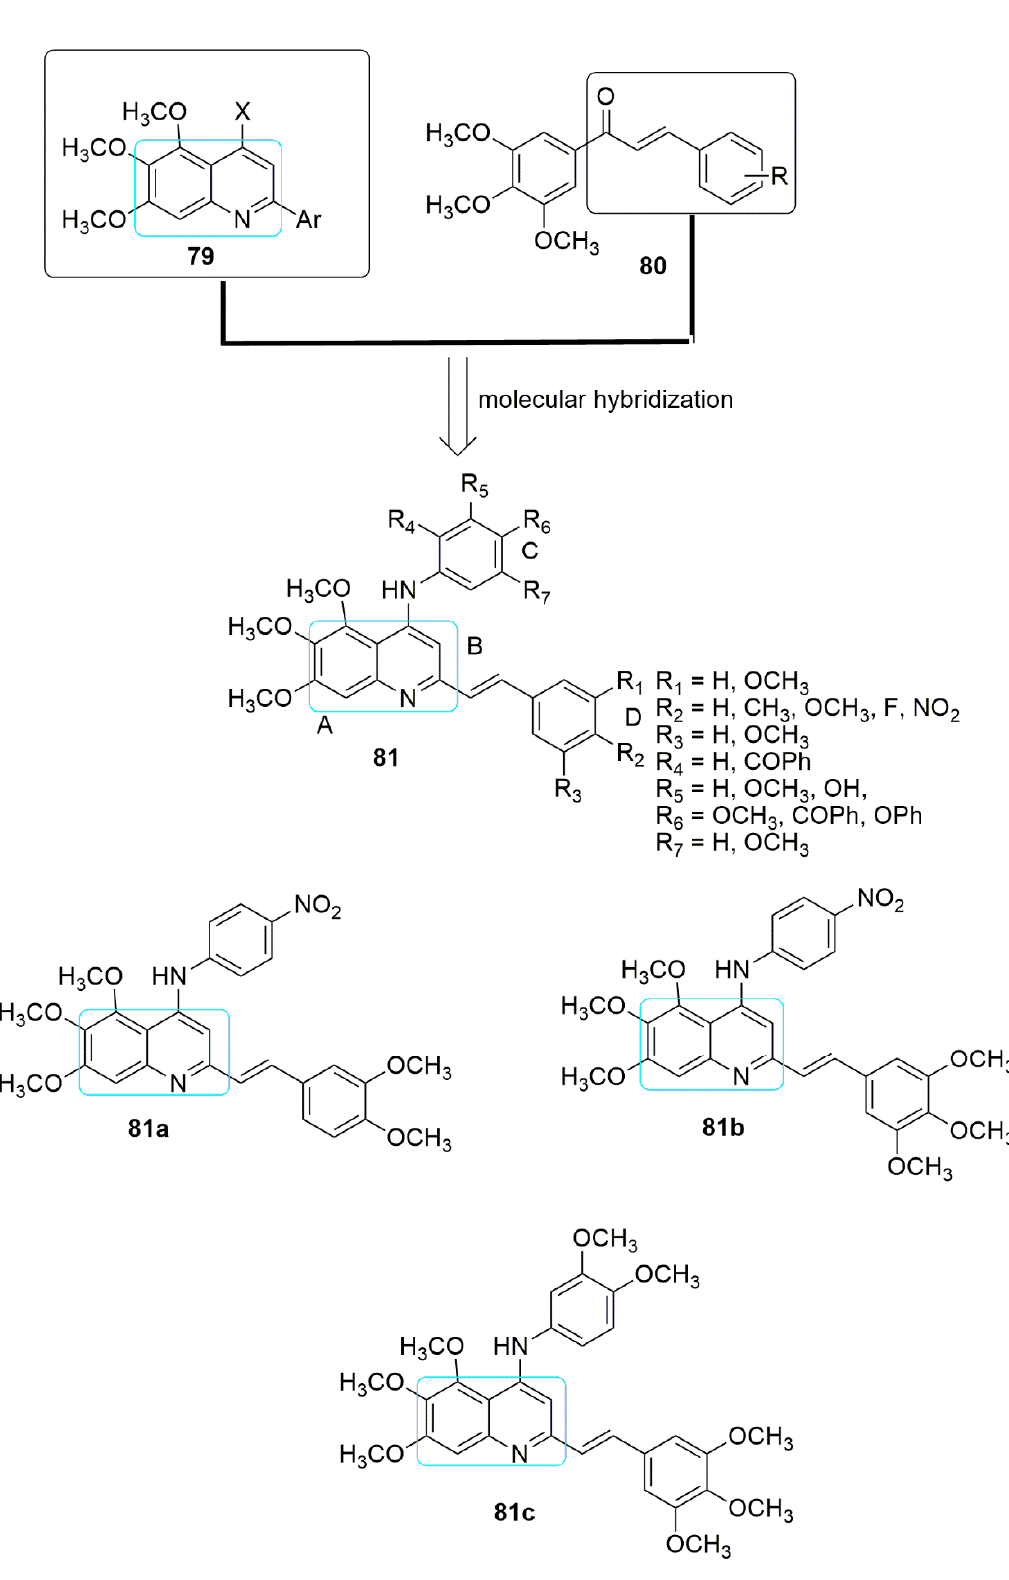
Figure 23. Promising anti-cancer agents and tubulin polymerization inhibitors. Table 5. Antiproliferative activity of compound 83a-c measured in IC 50 values (µM).